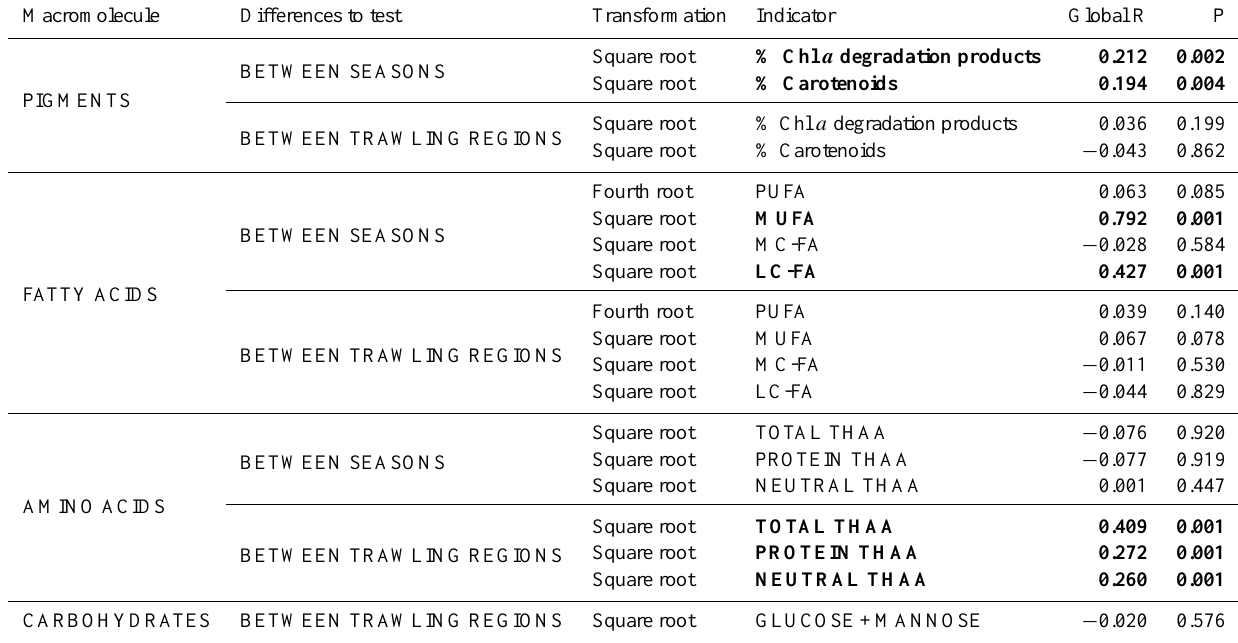
Table 3. Results of the multivariate statistical test ANOSIM for pigments (Chl a degradation products and carotenoids), fatty acids (PUFA, MUFA, MC-FA and LC-FA) amino acids (total THAA, protein THAA and neutral THAA) and carbohydrates (sum of glucose and mannose). Significant differences are shown in bold.